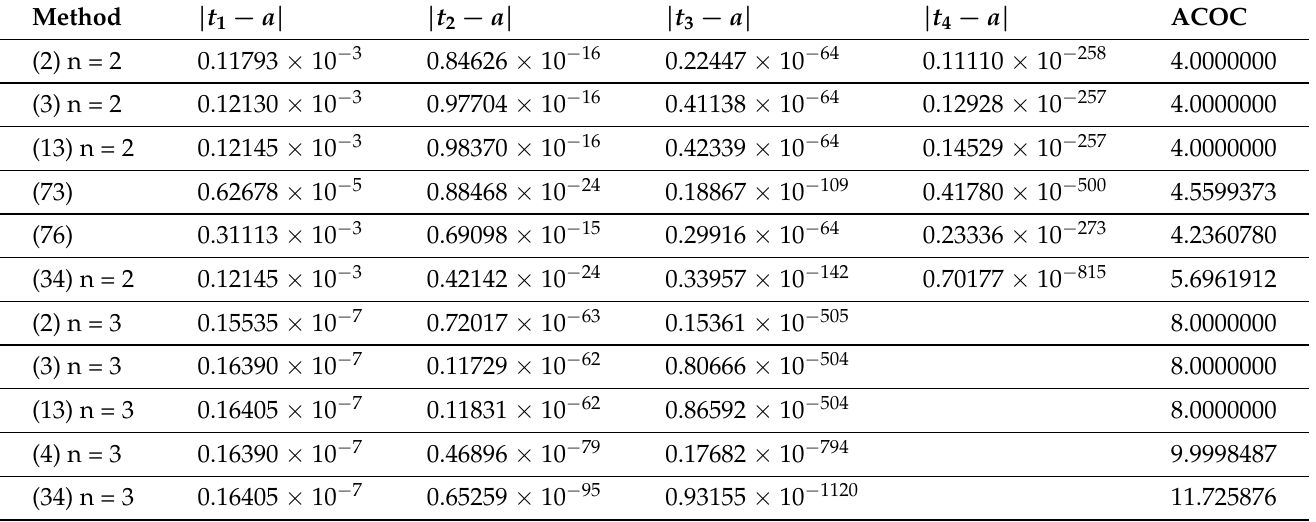
Table 7. Numerical results for f 2 ( t )